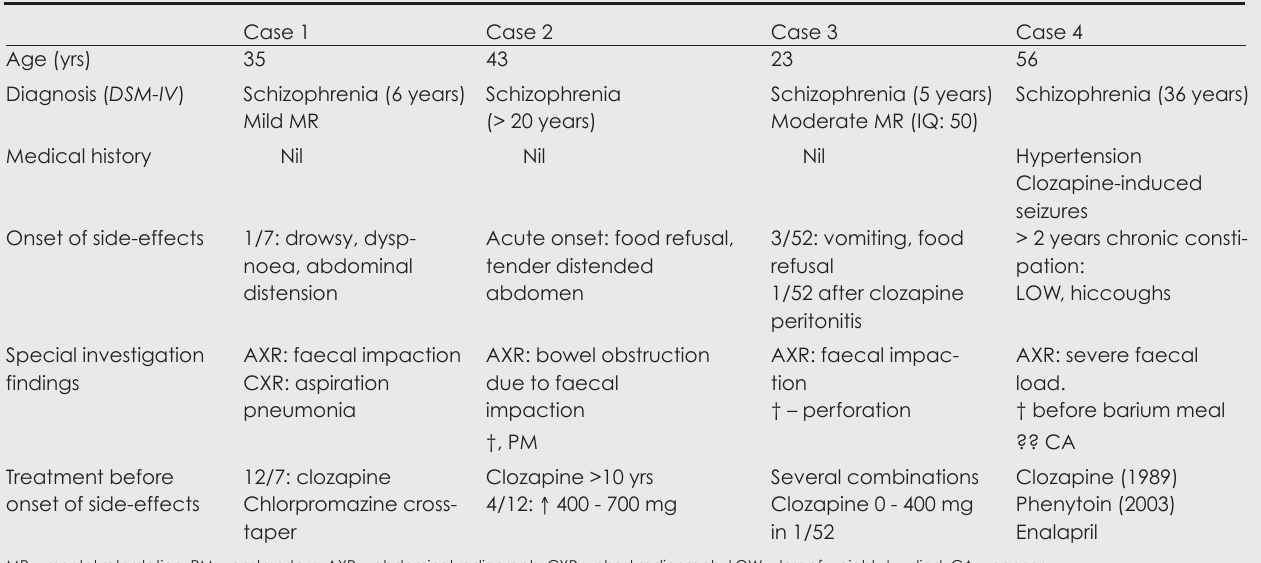
Table II. Summary of